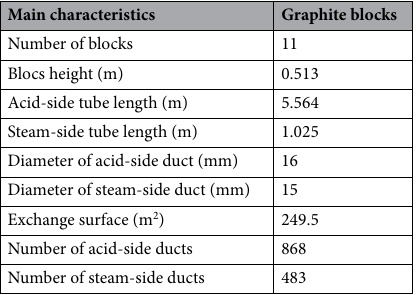
Table 1. Main characteristics of the studied heat exchanger.